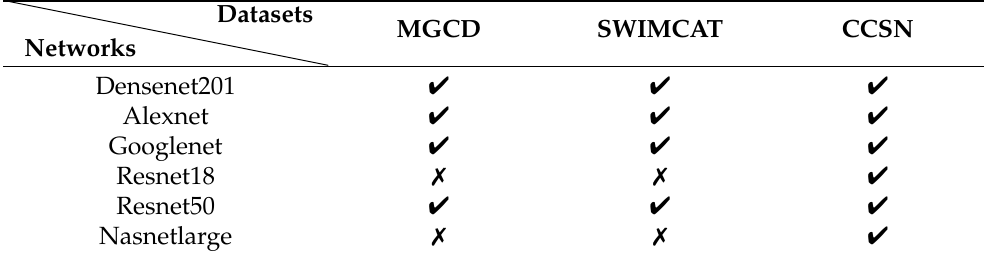
Table 5. Deep neural networks adopted with respect to